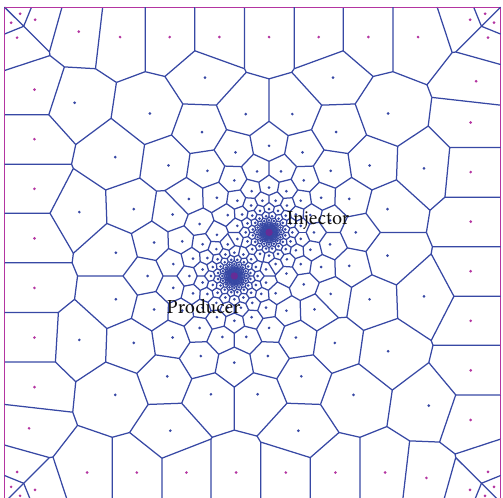
Figure 1: Computational domain and gridding.